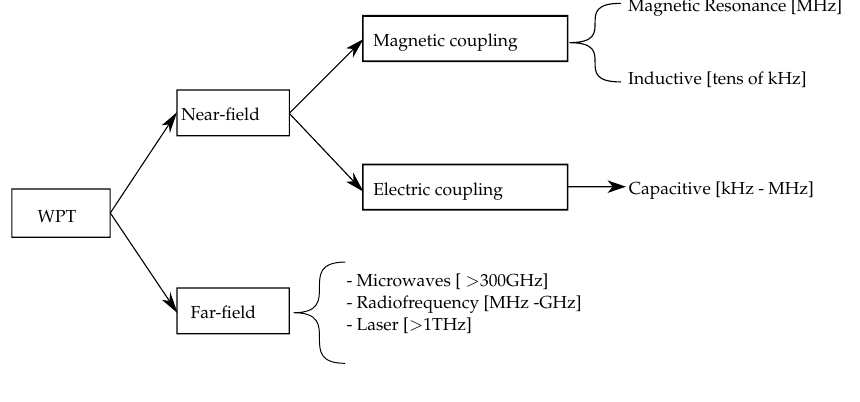
Figure 2. Overview of